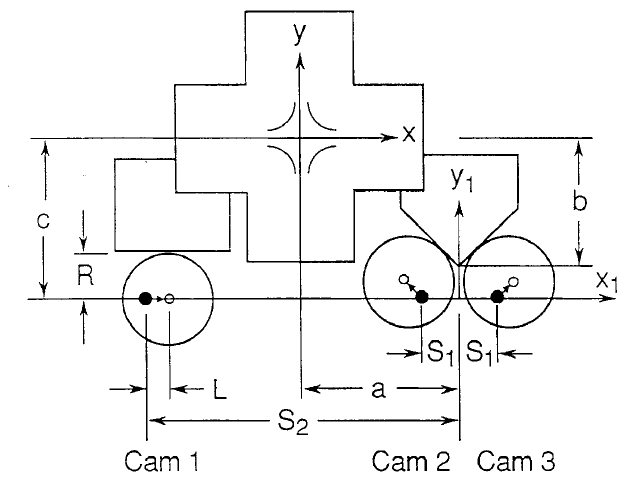
FIG. 9. Schematic vertical section of an ATF2 mover at its midrange